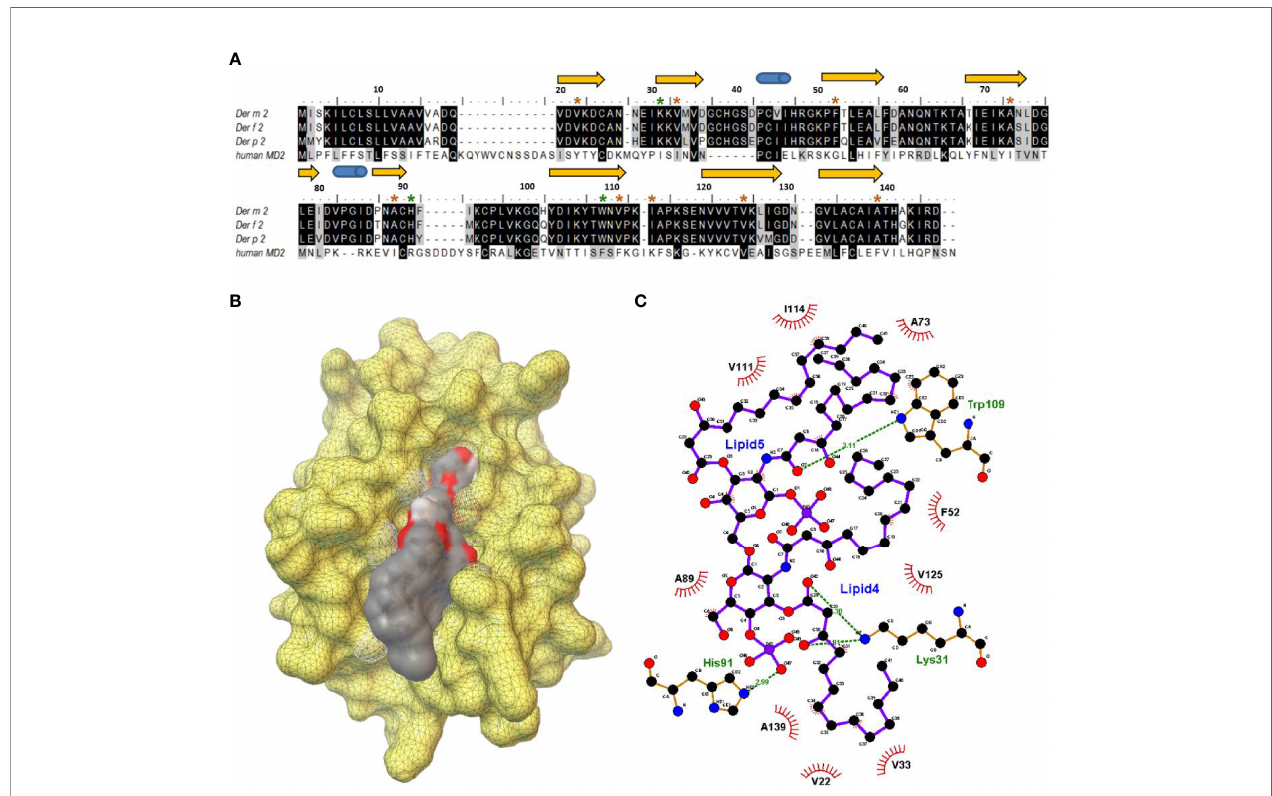
FIGURE 2 | The structural characterization between the putative Der m 2 protein and Lipid IVa complex. (A) The multiple-sequence alignment for the putative protein sequences of Der m 2 with Der f 2 (Q00855), Der p 2 (P49278), and human MD-2 (LY96, Q9Y6Y9) based on the SWISS-MODEL “ model-template ” mode. The secondary structure assignment of the immunoglobulin-like b -sandwich of ML-2-related lipid recognition domain dependent on the modeling domain of Der m 2 is shown above the sequences: arrows represented b -strands, and cylinders indicated a -helices. The color brown and green of star symbols above the sequences regarded the interesting residues of the hydrophobic contacts and hydrogen bonding interactions between Der m 2 and Lipid IVa, respectively. (B) The molecular docking simulation of Lipid IVa in the hydrophobic cavity of Der m 2 using the Scripps AutoDock vina package. The yellow color demonstrated the molecular surface of Der m 2 . The electrostatic potential of ligand lipid IVa revealed the negative electrostatic and hydrophobic contacts in color red and gray, respectively. (C) Schematic representation of key residues of the Der m 2 bound with the Lipid IVa ligand. The 2D diagram was generated with LigPlot+ that hydrogen bonds are shown as green dotted lines, while the spoked arcs represented residues making hydrophobic contacts with the